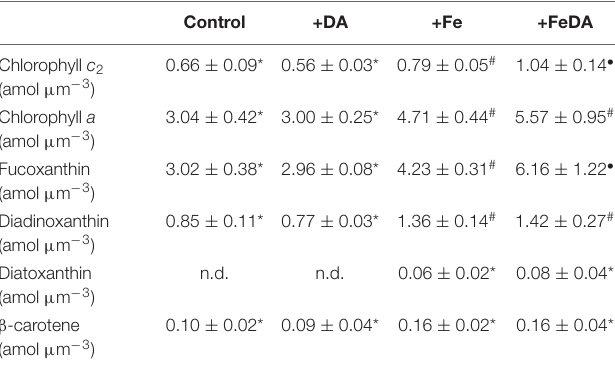
TABLE 4 | Cellular pigment content in P. subcurvata grown in the four different treatments, normalized to cell volume.